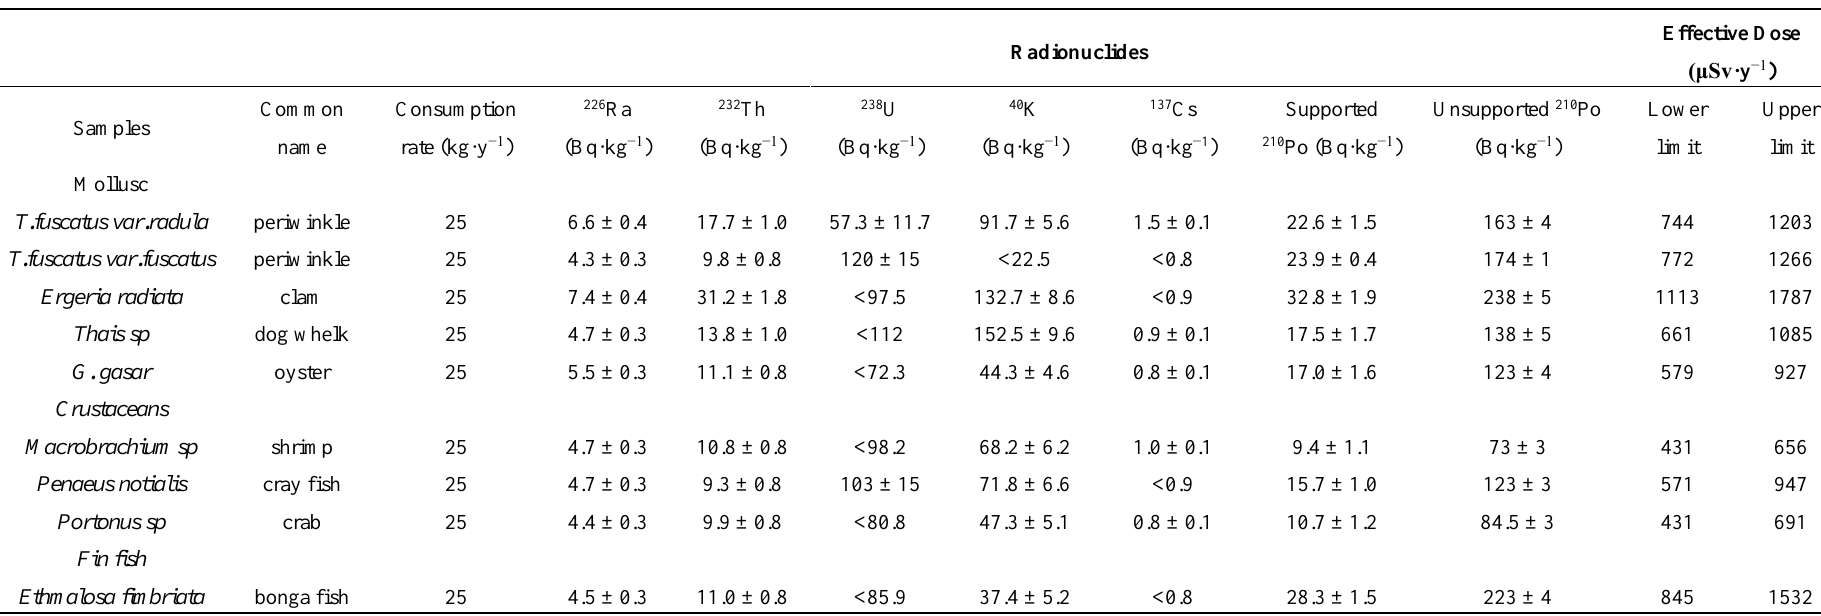
Table 3. Radionuclide concentration and effective dose estimate in fish samples from Bonny estuary, Niger Delta, Nigeria. The errors quoted are 1σ based on the propagation of counting statistics, except for 210 Po data, which are based on the triplicate analysis of the